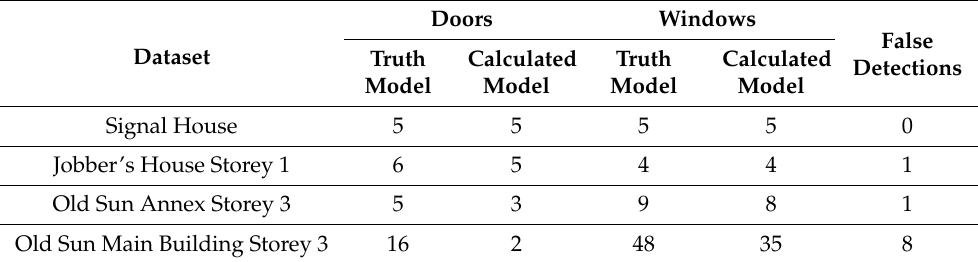
Table 2. Door and window extraction results.